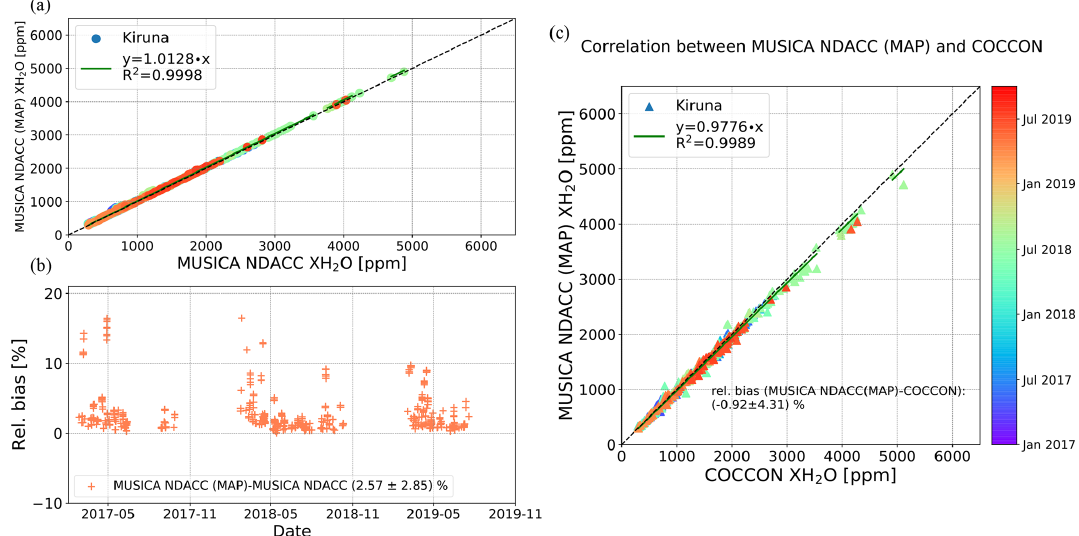
Figure 6. (a) Correlation plot of MUSICA NDACC XH 2 O and MUSICA NDACC (MAP), (b) time series of their relative bias, and (c) correlation plot of COCCON XH 2 O and coincident MUSICA NDACC (MAP) retrievals at the Kiruna site. The annotations follow those in Fig. 2.